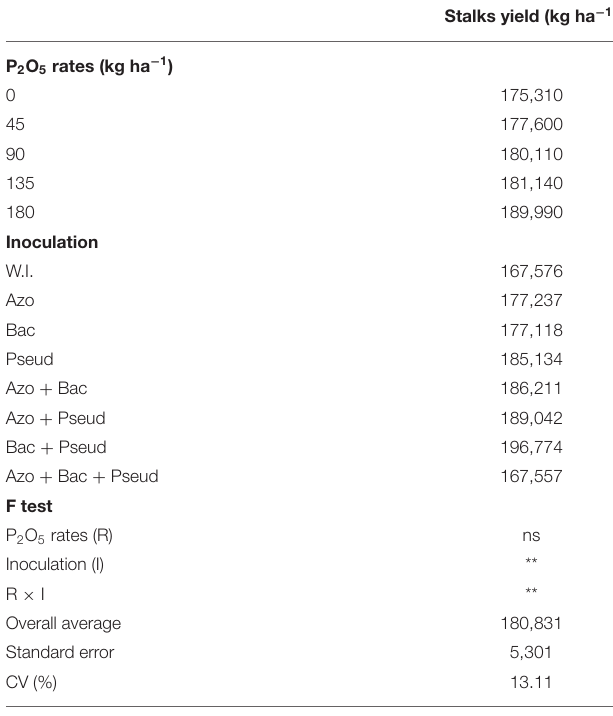
TABLE 9 | Stalks yield of sugarcane as influenced by different bacterial inoculations and P 2 O 5 doses.